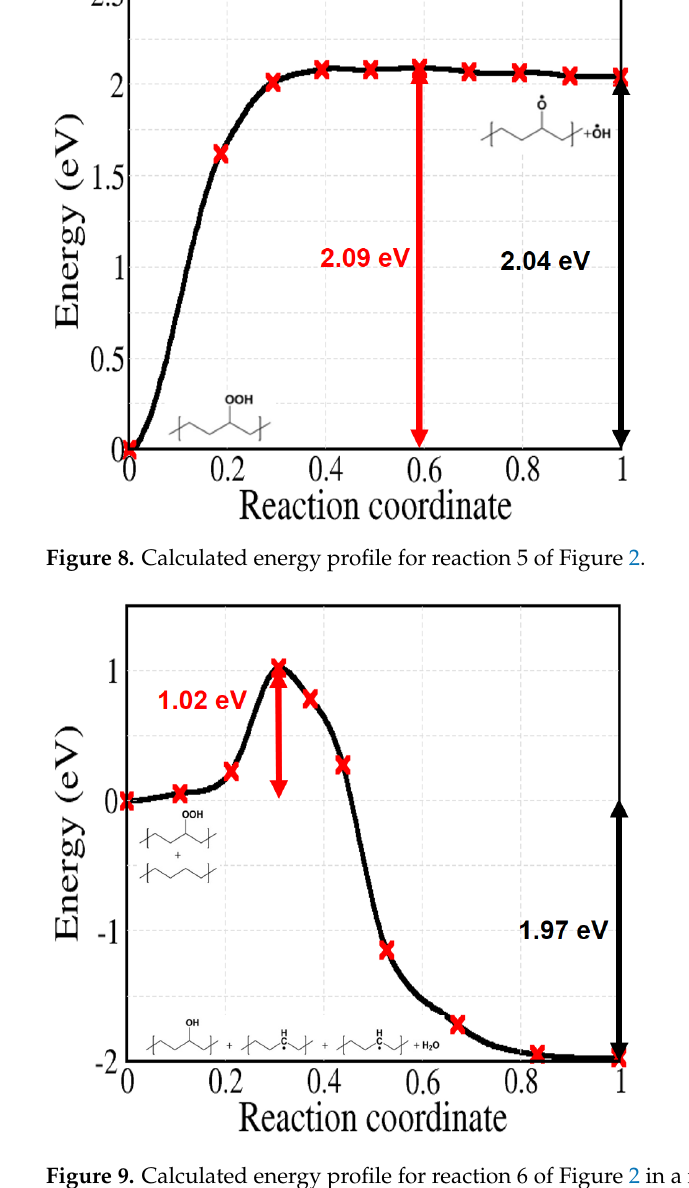
Figure 9. Calculated energy profile for reaction 6 of Figure 2 in a model of crystalline PE. The calcu- lated outcome is here different from the commonly accepted one, giving instead two alkyl radicals and an alcohol, plus a water